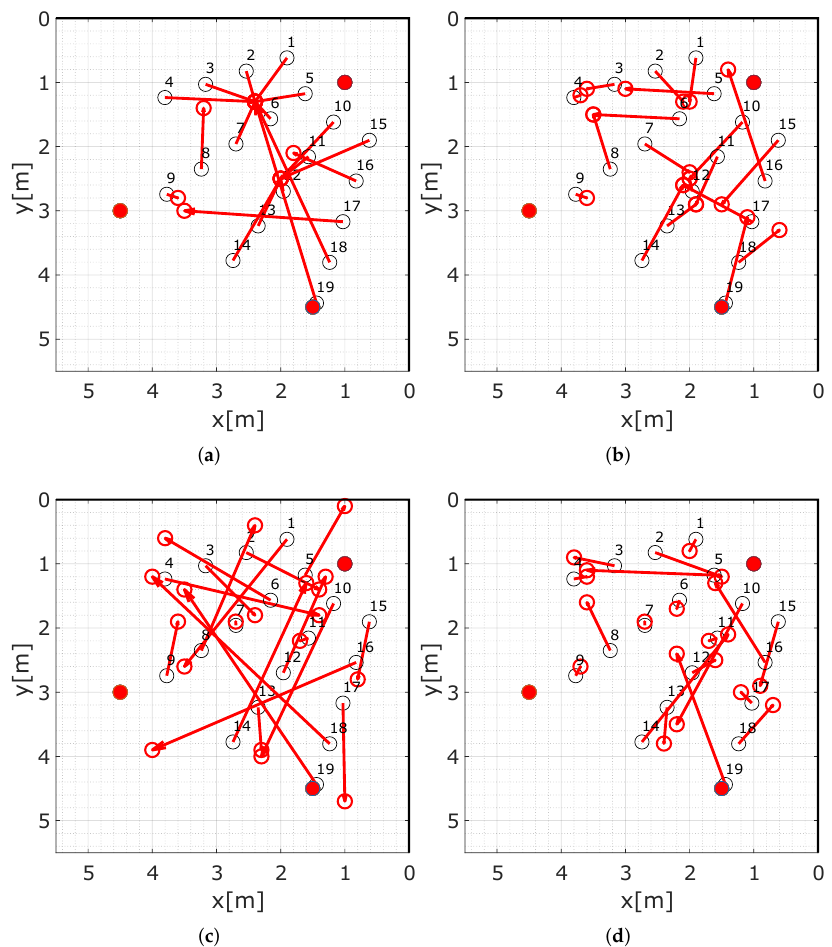
Figure 15. Localization results for the DFL methods. ( a ) Localization results for RTI. ( b ) Localization results for MA-RTI. ( c ) Localization results for MSR. ( d ) Localization results for the